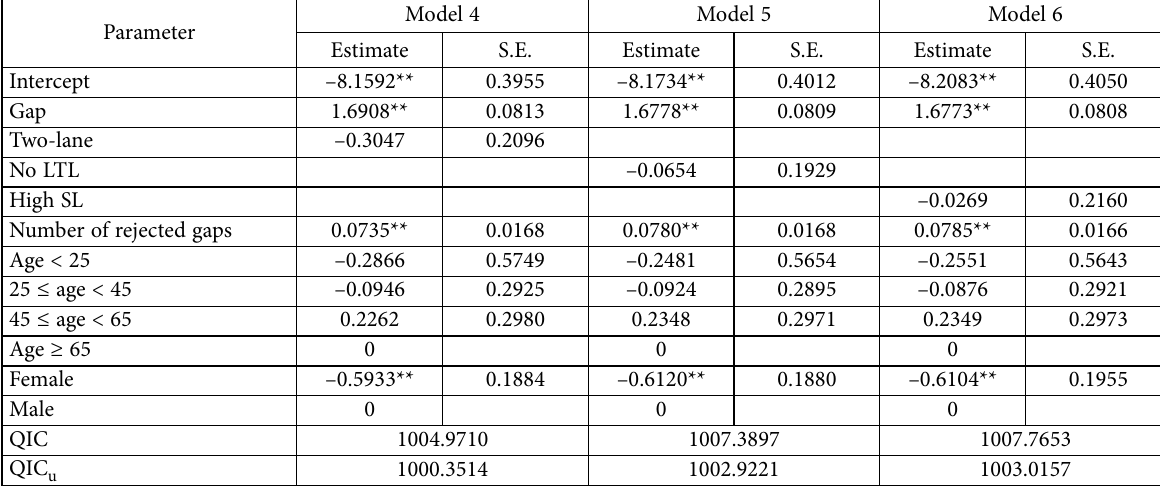
Table 6. Parameter estimates of the models on the number of rejected gaps